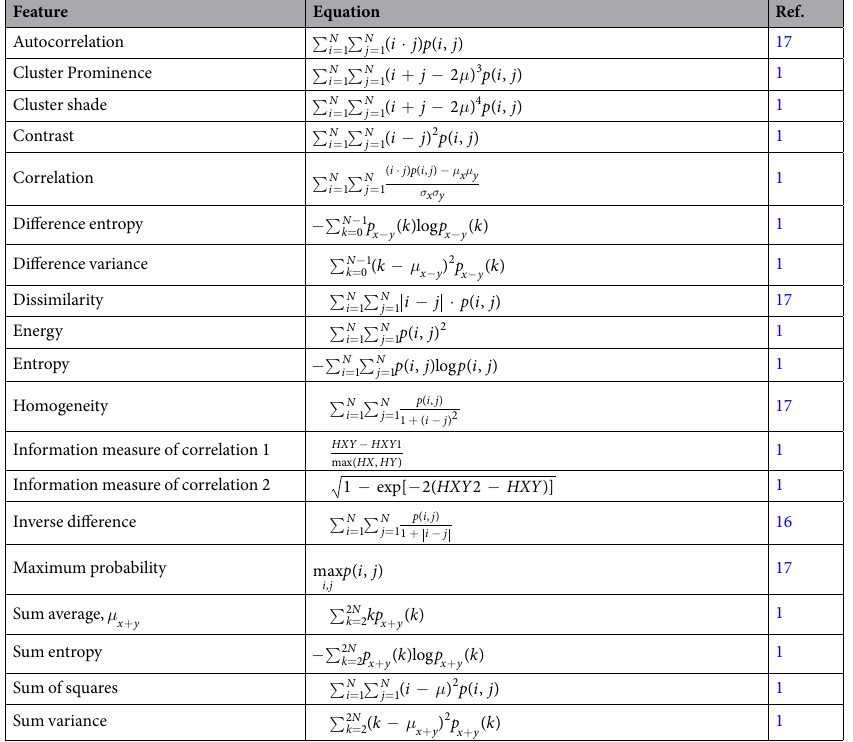
Fig. 1. One way of decreasing the influence of the GLCM size on the values of the texture features is to normalize the indices, → i j i N j N ( , ) ( / , / ) where N is the number of gray levels. This has previously been used by Soh et al . 17 to compare texture features across different quantization schemes, and Clausi et al . 16 introduced two normalized features to improve classification. The quantization method had a significant impact on 15 of 19 features is the glioma data set and 13 of the 19 features in the prostate data set. The choice of how to quantize the images impacts the values of the texture features and different methods should be considered depending on what the underlying images show. Figure 6 shows a large spread in the range of ADC values in the ROIs for both the glioma and prostate data set. A value above 3000 mm 2 /s in an ROI usually indicates liquid, such as cerebro-spinal fluid (CSF) in the brain or urine in the prostate region, and a value of 0 mm 2 /s indicates a region with no signal. In patients where the ROI is close to the ventricles or the bladder, the texture feature values can be very dependent on the definition of the ROI if the AutoROI or AutoSlice methods are used. An example of this is shown in Table 1, where the change in texture features for AutoROI and manual quantization methods were calculated when expanding the ROI with one voxel in a slice from the glioma data set where the tumor is close to the left lateral ventricle, see Fig. 3. A change of one voxel can be due to e.g. inter-operator variability, or a registration error. The minimum and maximum values inside the ROI changed from 310–1344 mm 2 /s to 209–1827 mm 2 /s due to the expansion. Of the 19 features, only cluster prominence and maximum probability showed a smaller change in feature values using AutoROI. Hence, if the ROI is close to values much larger or smaller than inside the ROI, a manual quantization method should be used. If CSF and signal void are believed to be important features in the ROI of brain tumors, a limit like 0 – 3000 mm 2 /s might be used. A narrower ADC range such as 500–1500 mm 2 /s contains white matter, gray matter and tumors but excludes CSF and signal voids. This approach minimizes the variations caused by uncertainties in the ROI, and decreases the likelihood of discretizing so that important texture features are hidden, as shown in Fig. 5. Resolution had a significant impact on about half the features, see Fig. 2. As can be expected, the difference between 1.2 and 1.8 mm is not very large, whereas the difference between 1.2 and 3.6 mm is significant in all fea- tures affected by resolution, see Fig. 1. Noise had a small but significant impact on all features for the glioma data set and a significant impact on 15 of 19 features of the prostate data set. The difference is most likely due to the inherent difference in the signal to noise ratio, SNR, in the tumors between the two data sets.